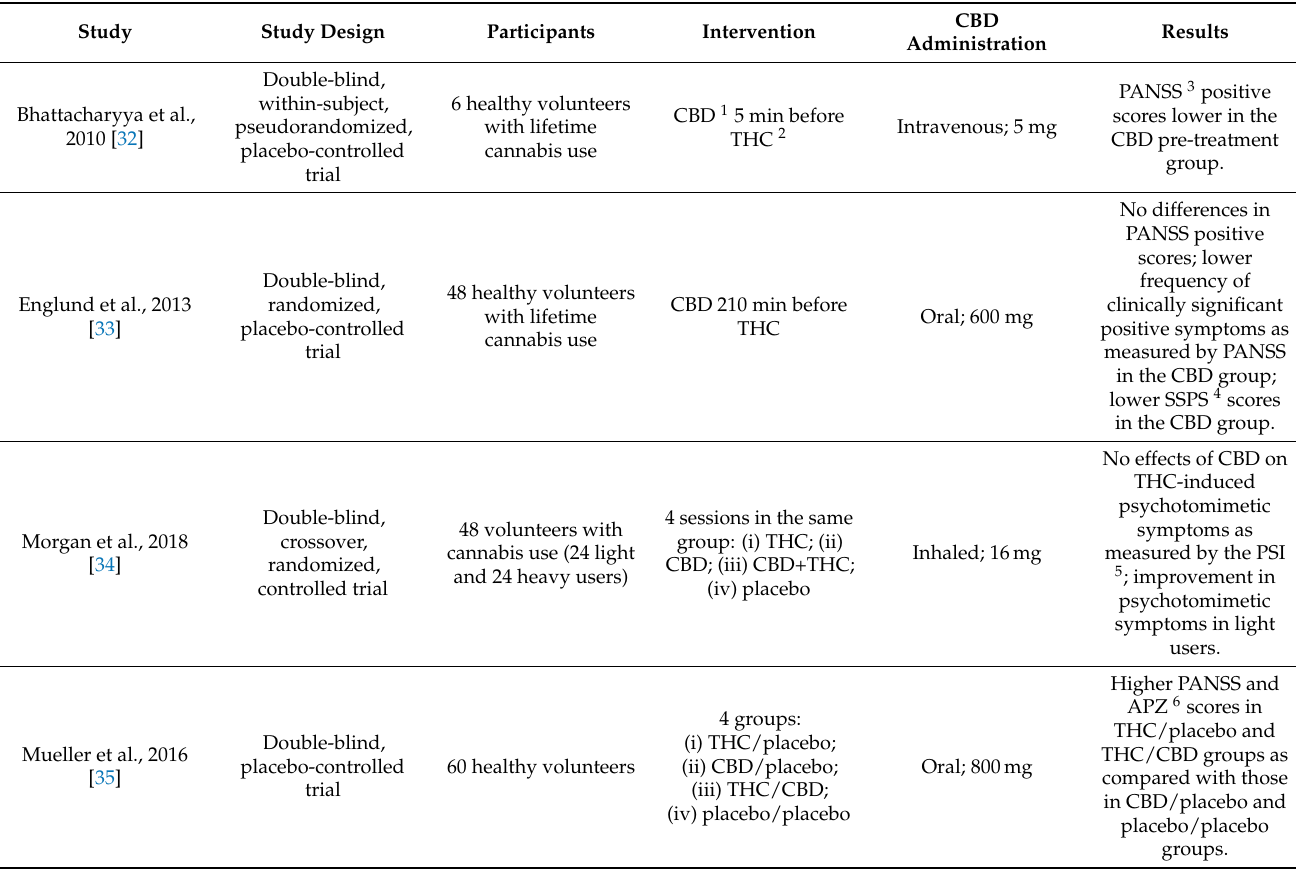
Table 1. Clinical studies testing the acute effects of Cannabidiol on ∆ -9-tetrahydrocannabinol-induced psychotic symptoms in healthy